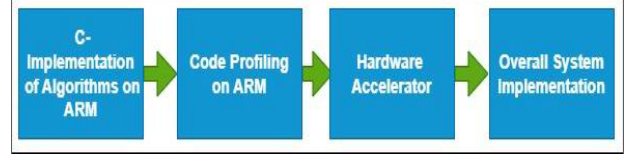
Fig. 4. Hardware implementation